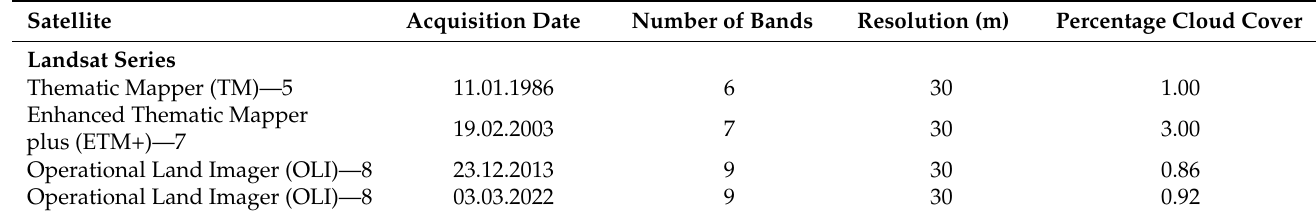
Table 1. Raster data utilised in this study.